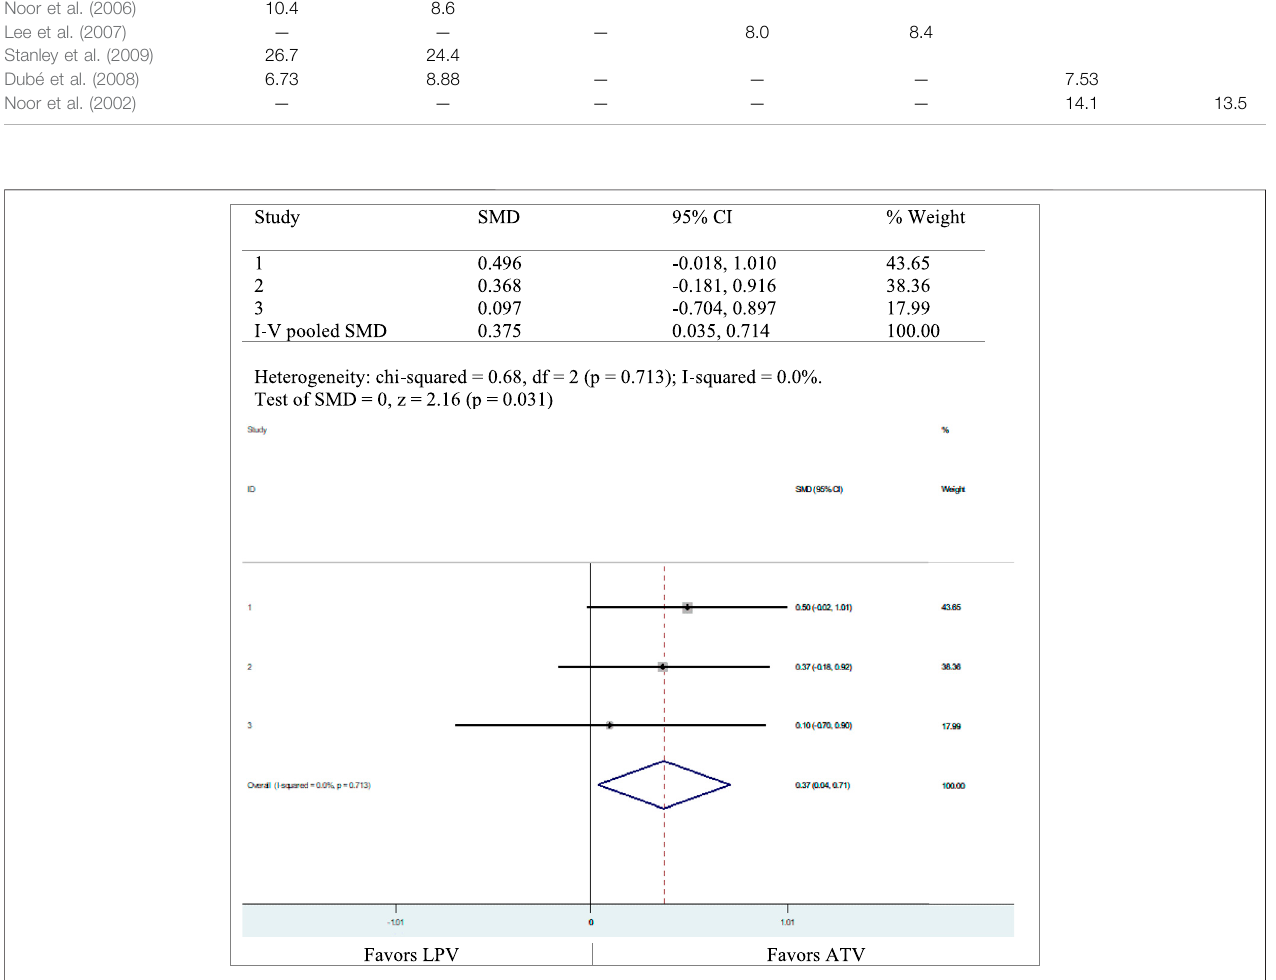
FIGURE 3 | Glucose disposal rate, LPV versus ATV.